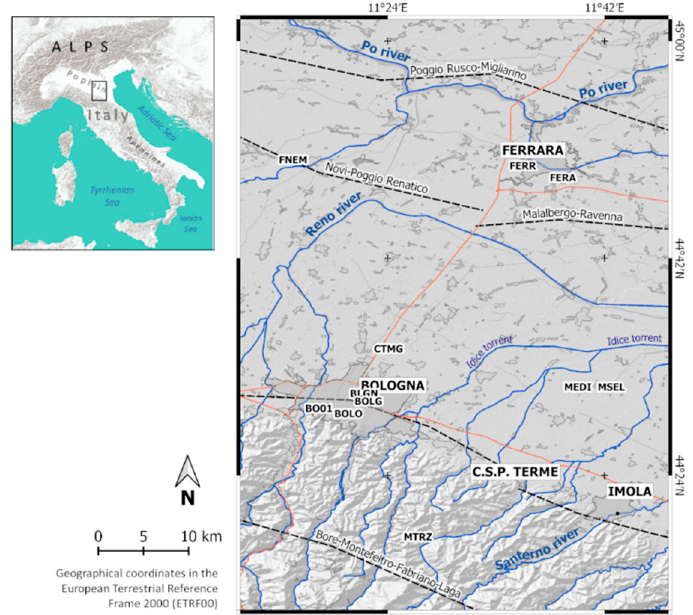
Figure 1. Map of the study area, including the main urbanized areas and seismogenic faults (dotted lines, SHARE project, [38]. Eleven continuous global navigation satellite system (CGNSS) sites used in the present work as constraint to a reference frame and validation purposes are located. Labels, composed of four alphanumeric codes, are printed above the CGNSS locations.